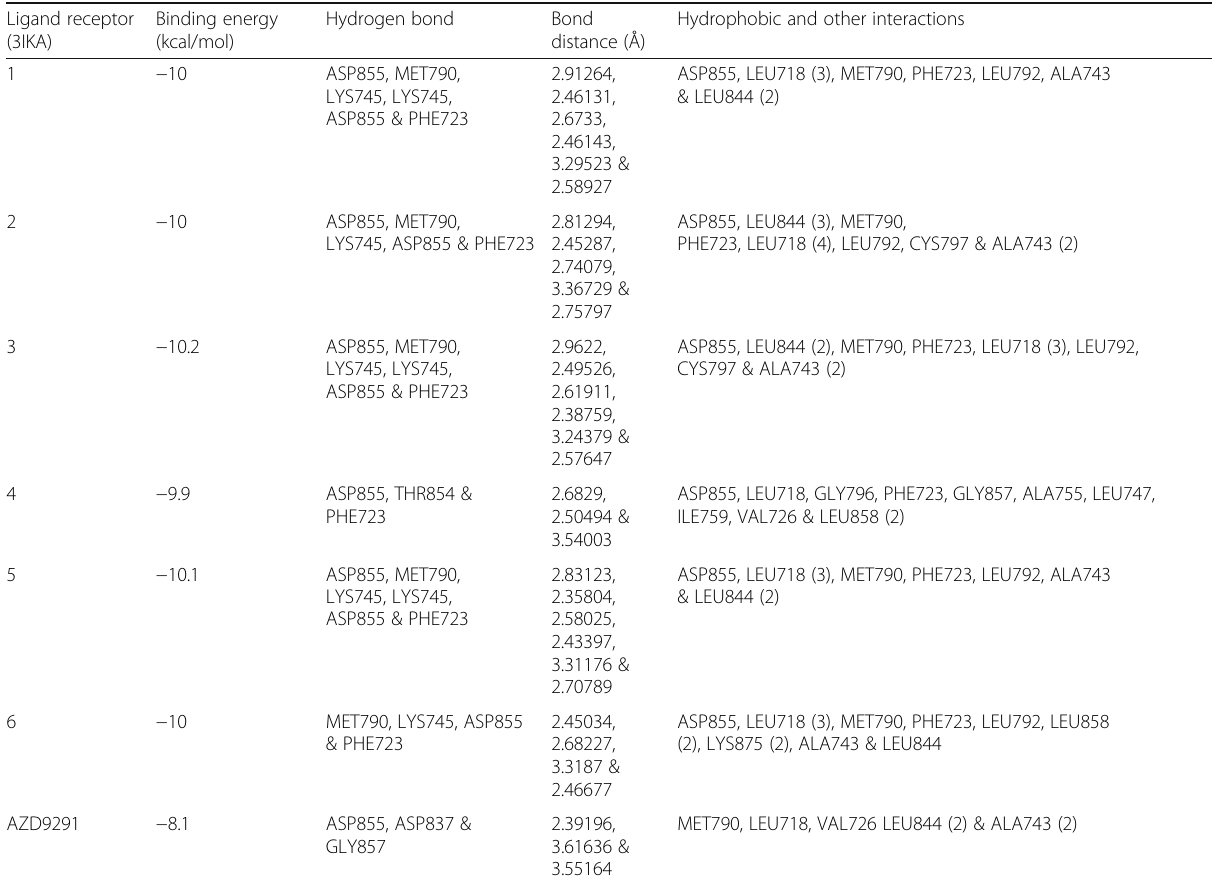
Table 6 The interactions of the designed compounds in the active site of the EGFR receptor Ligand receptor (3IKA)